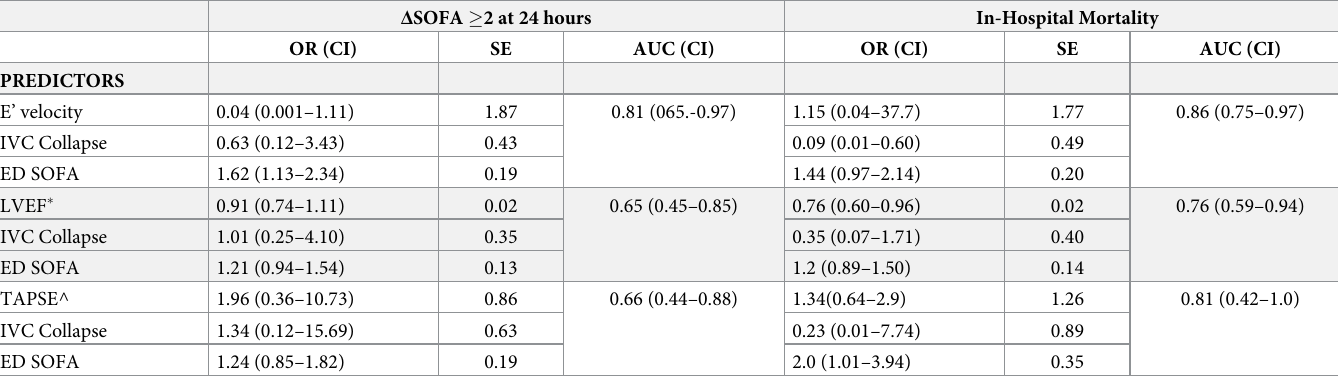
(only measured in 7 patients), mechanical ventilation, vasopressor use, and creatinine (the lat- ter 3 included in SOFA score) were greater in the DS2 and non-survivor group. From 146 total echocardiograms, 13 were missing at least one e’ value (n = 8 in DS2 group), 12 were missing TAPSE (n = 7 in DS2 group), and 0 were missing LVEF. Missing ED SOFA values included Pa0 in 44 patients (n = 7 in DS2 group) and bilirubin in 22 patients (n = 7 in 2 DS2 group); at 24-hours: Pa0 in 48 patients (n = 7 in DS2 group), and bilirubin in 51 patients 2 (n = 8 in DS2 group). For the primary outcome, e’ velocity was not associated with DS2, after adjustment for base- line (ED) SOFA score. Similarly, neither LVEF nor TAPSE were associated with DS2 (Table 2). Additionally, there was no adjusted association between Δ e’ (0–3 hours) and DS2. Change in LVEF from 0–3 hours ( Δ LVEF), adjusted for LVEF-ED SOFA score interaction and IVC collapse was associated with DS2, however. The relationship between Δ LVEF at 3 hours and DS2 is depicted graphically in Fig 1, stratified by IVC collapsibility, showing that the impact of Δ LVEF on the probability of DS2 varies by ED SOFA score, with minimal difference between IVC groups. For patients with greater ED SOFA scores, declining LVEF is associated with a lower probability of DS2 than static or increased LVEF, while the inverse relationship is seen with lower ED SOFA scores. A similar relationship was seen for Δ TAPSE (See S1 Fig in S1 File). Table 2. Parameter estimates from logistic regression